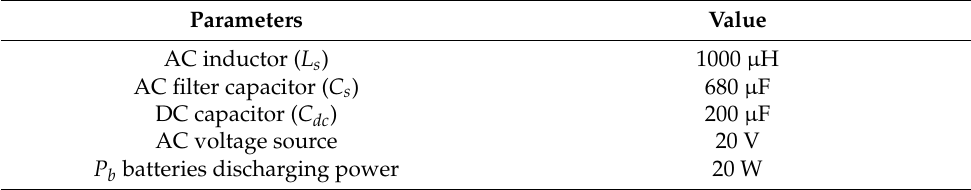
Table 1. Experimental platform parameters of